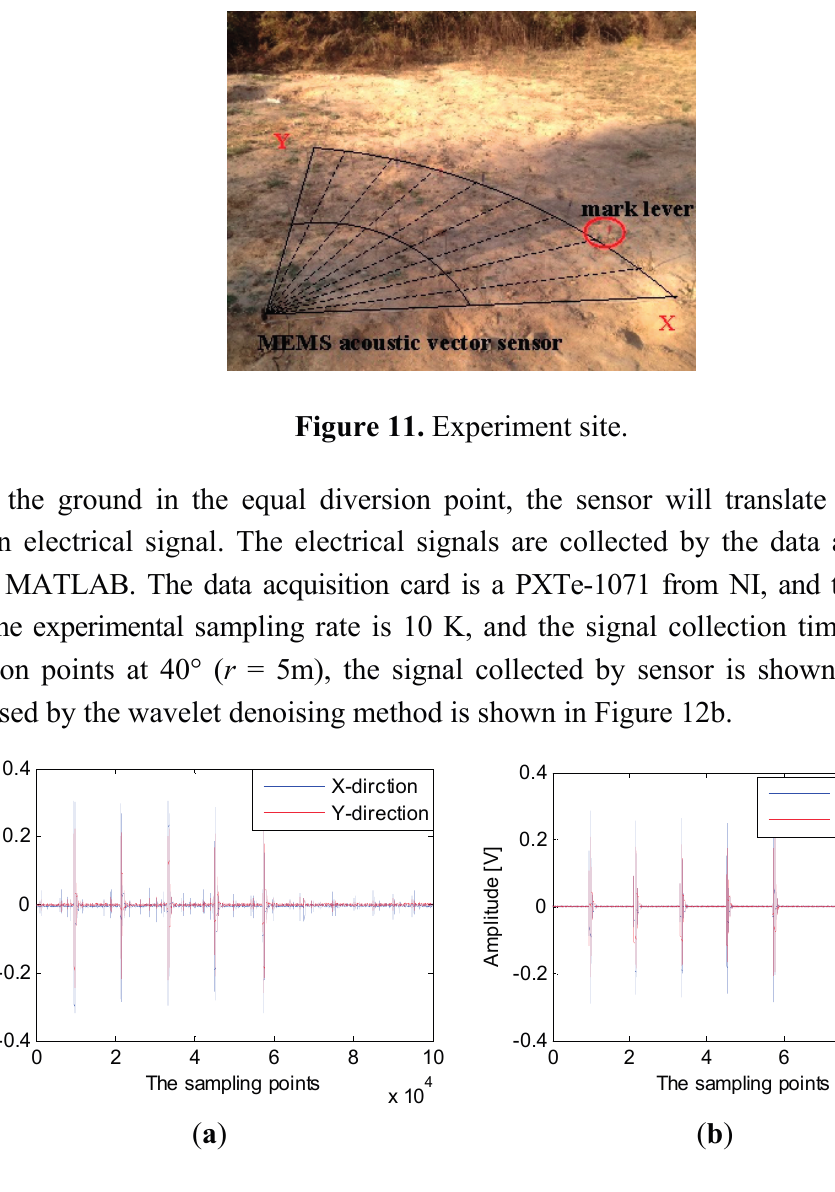
Figure 12. Signal collected by MEMS acoustic vector sensor ( a ) The original signal; ( b ) the filtered